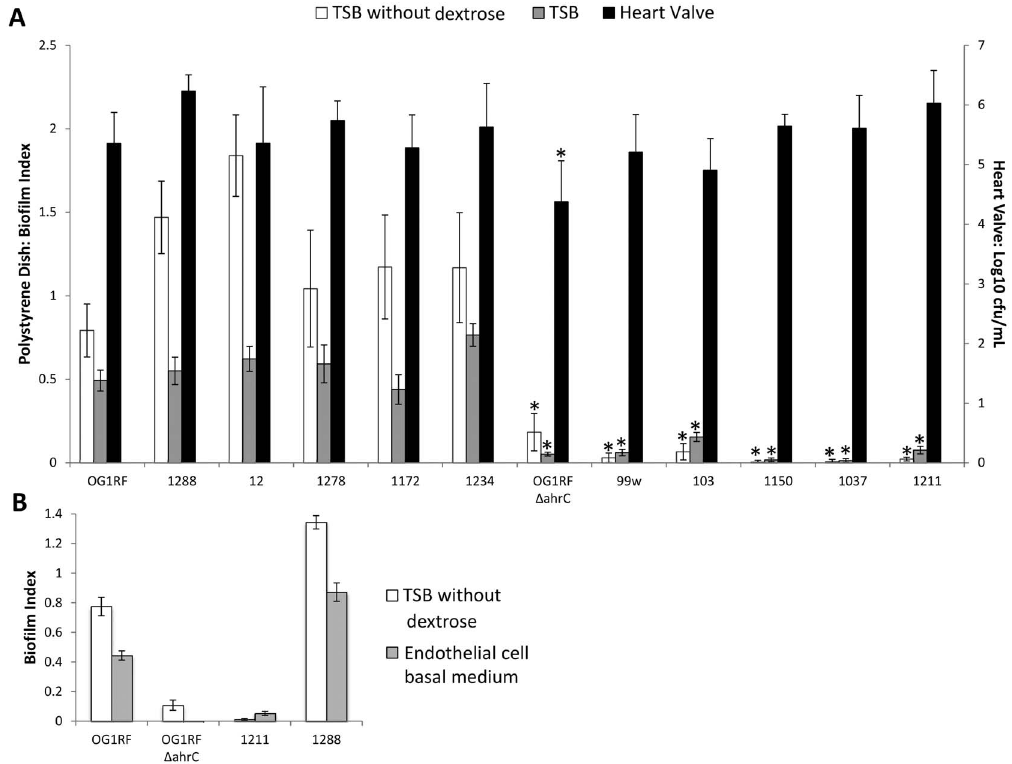
Figure 3. Comparison of Enterococcusfaecalis biofilm formation using a polystyrene dish assay and an ex vivo heart valve assay. A: The laboratory strain OG1RF and clinical isolates with high-level biofilm formation, as indicated by a biofilm index . 1.0 in the standard polystyrene dish assay (strains 12, 1172, 1234, 1278, and 1288), were compared to OG1RF D ahrC (a mutant with attenuated biofilm formation) and clinical isolates with low-level or no biofilm formation, as indicated by a biofilm index , 0.1 (isolates 99w, 103, 1037, 1150, and 1211). Isolates were compared using the polystyrene dish assay with tryptic soy broth (TSB) (0.25% dextrose) and TSB without dextrose, and using an ex vivo porcine heart valve explant assay (with medium that contains 0.1% dextrose). Polystyrene dish assays were incubated for 24 hours; heart valve assays were incubated for 4 hours. *indicates p , 0.01 for less biofilm formation compared to OG1RF (for the same conditions). Note that in the heart valve assay the only strain with a significant reduction in biofilm formation compared to OG1RF is OG1RF D ahrC. B: For a selection of strains representing a variety of phenotypes, biofilm formation relative to OG1RF was similar whether TSB without dextrose or endothelial cell basal medium (the medium used for the heart valve assay) was used. Error bars represent standard deviation. r 2 =0.98, p=0.018.